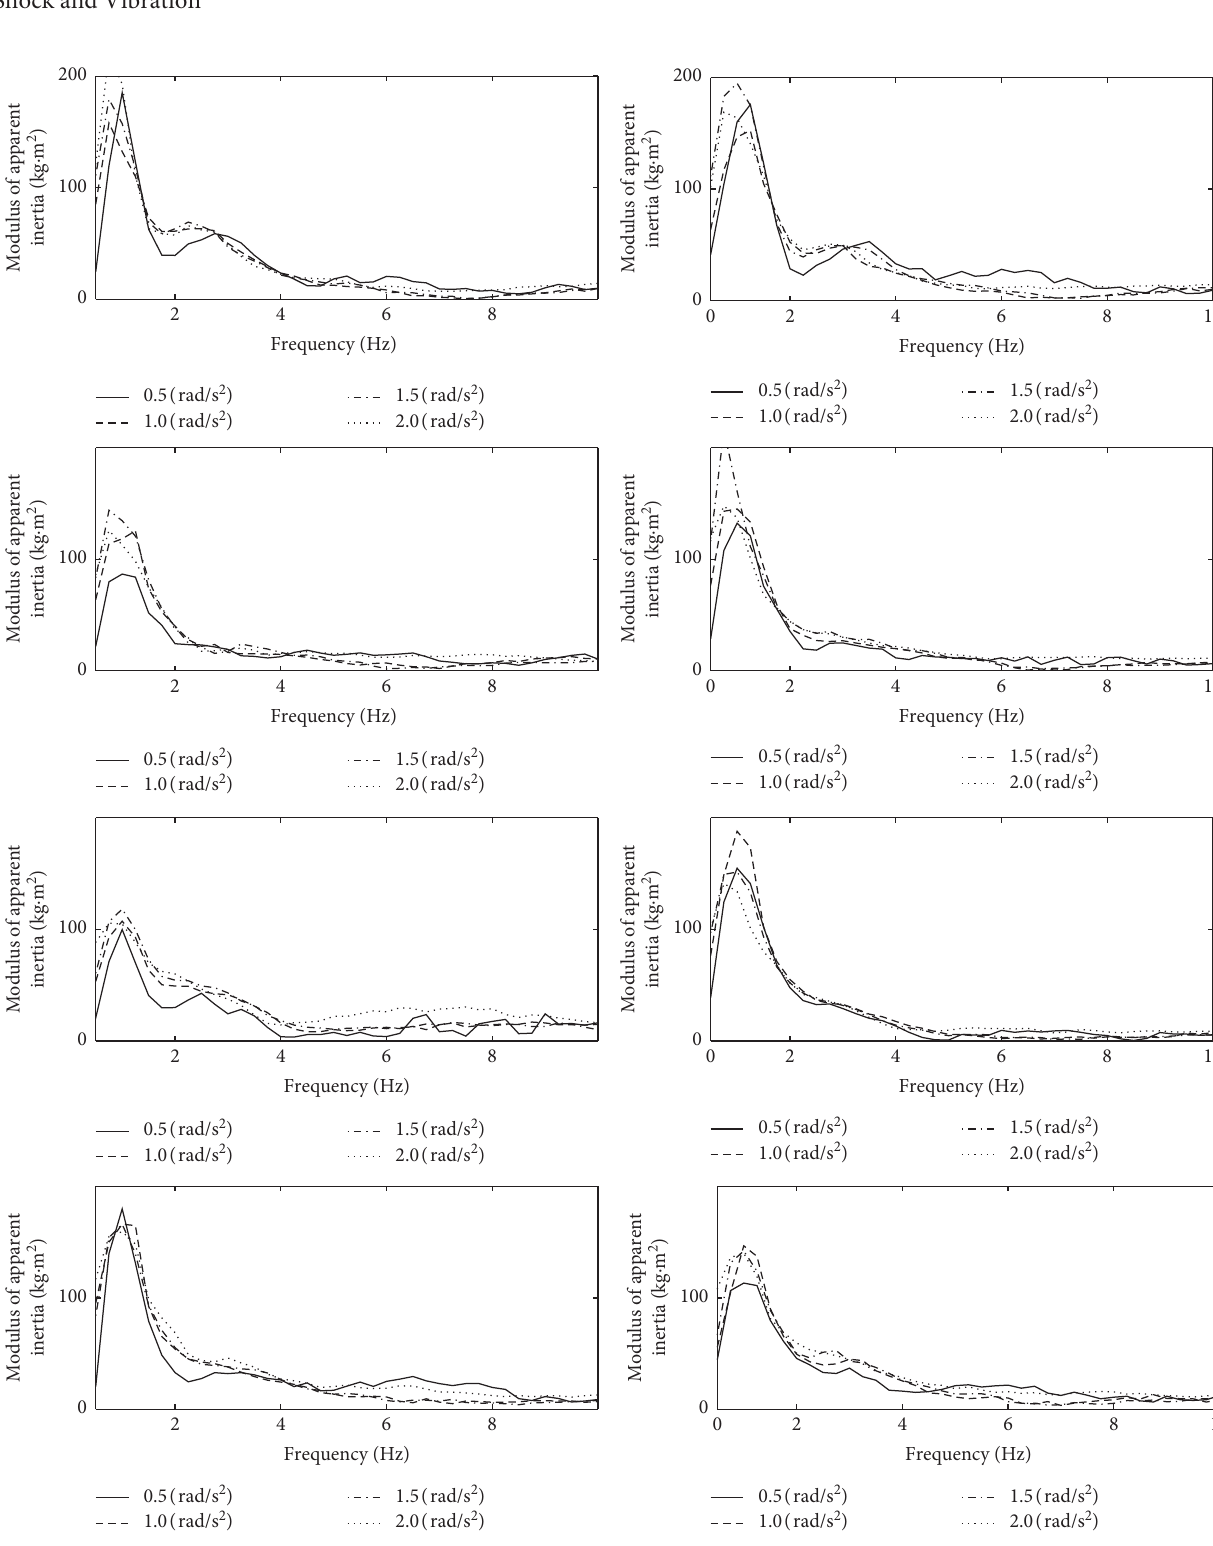
Figure 4: Apparent inertia of eight subjects at 4 magnitudes of